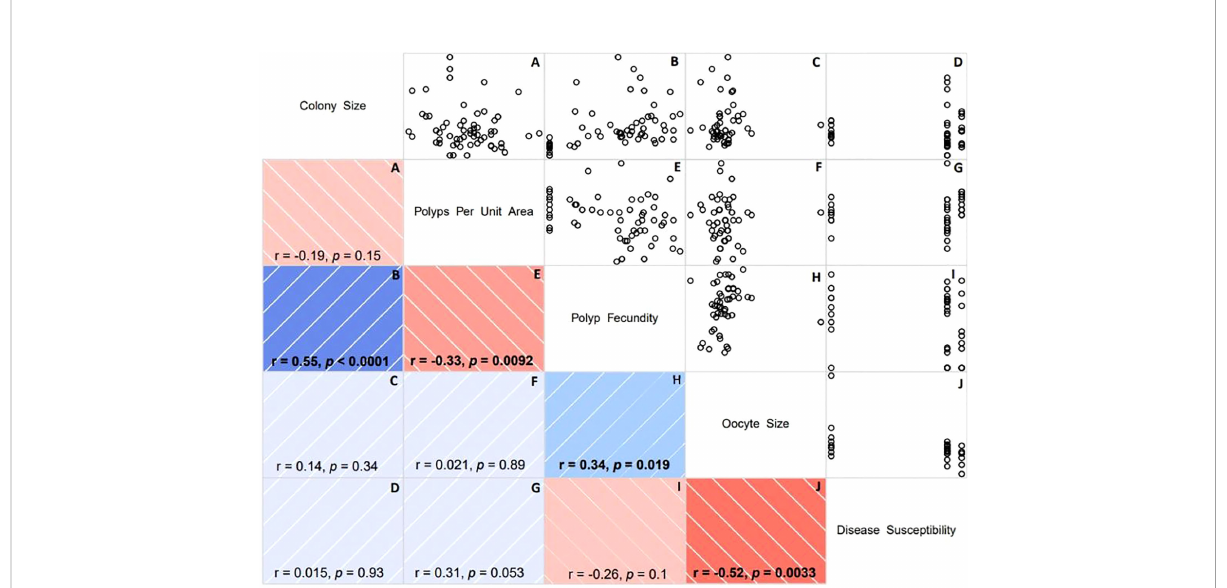
FIGURE 2 Correlogram (correlation matrix) displaying the relationship between each pair of numeric variables as part of the fragment fecundity analysis. (A) Colony Size & Polyps Per Unit Area; (B) Colony Size & Polyp Fecundity; (C) Colony Size & Oocyte Size; (D) Colony Size & Disease Susceptibility; (E) Polyps Per Unit Area & Polyp Fecundity; (F) Polyps Per Unit Area & Oocyte Size; (G) Polyps Per Unit Area & Disease Susceptibility; (H) Polyp Fecundity & Oocyte Size; (I) Polyp Fecundity & Disease Susceptibility; and (J) Oocyte Size & Disease Susceptibility. Disease susceptibility, quanti fi ed as the probability of disease, ranges from 0 (maximum resistance) to 1 (maximum susceptibility) (see Muller et al. 2018). Scatterplots for each pair of variables is mirrored by visualization of the correlation coef fi cient including the direction (color) and strength of the association (color intensity). Blue indicates a positive association/correlation while red represents a negative one. Color intensity is proportional to the correlation coef fi cient where dark blue or red indicates a stronger association and vice versa. For each pair of variables, we calculated rank-based correlation coef fi cients using Spearman ’ s rho (r). The signi fi cance of the correlation is indicated by the p-value. Signi fi cant correlations are bold in the